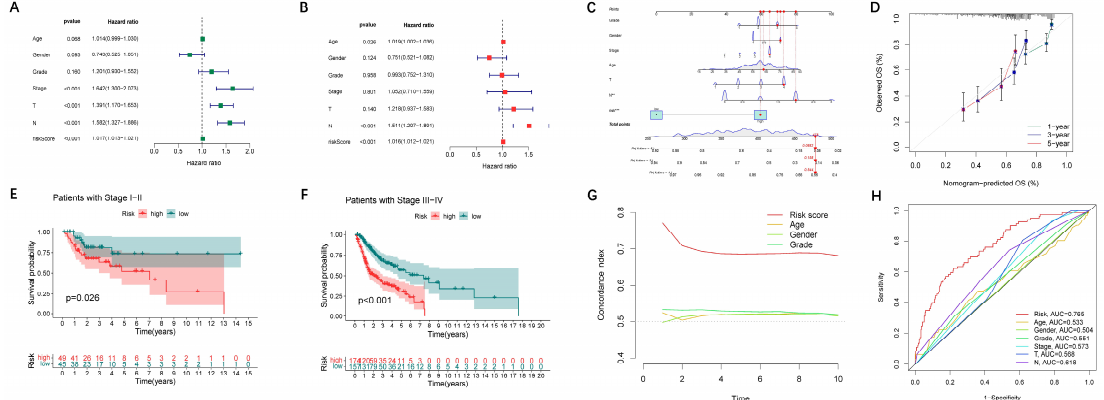
Figure 7. Assessment of the prognostic risk model of the 24 oxidative lipid metabolism-related lncRNAs in HNSCC. ( A , B ) The univariate and multivariate Cox regression analysis of the risk scores and clinical characteristics for prognostic value. ( C ) The nomogram model is based on a risk score, age, gender, grade, tumor size (T), lymph node metastasis (N), and tumor stage. ( D ) The calibration plots are for the 1-, 3-, and 5-year overall survival. ( E , F ) The Kaplan–Meier curves are for the tumor stage-based subgroup analyses. ( G ) The C-index is for the risk scores, grade, age, and gender. ( H ) ROC curves for the risk scores and the clinical characteristics for predicting prognosis.